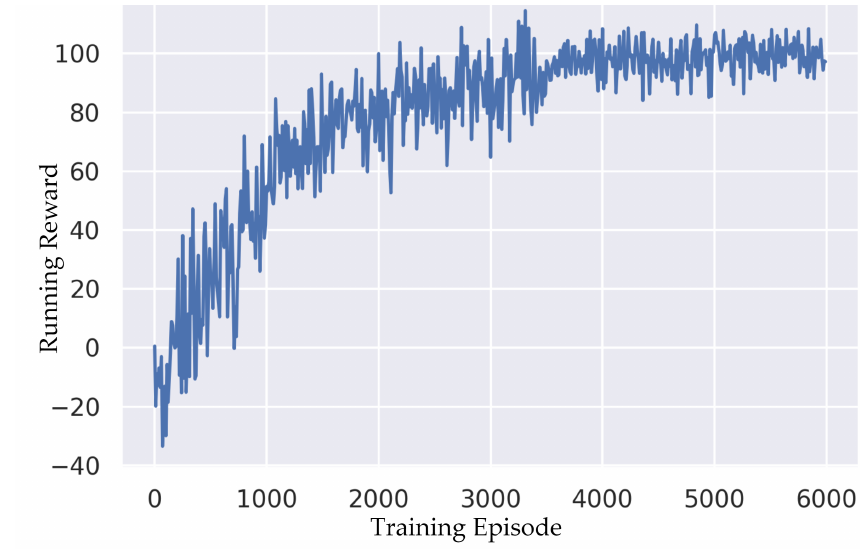
Figure 7. Running reward across training episodes for the SAC